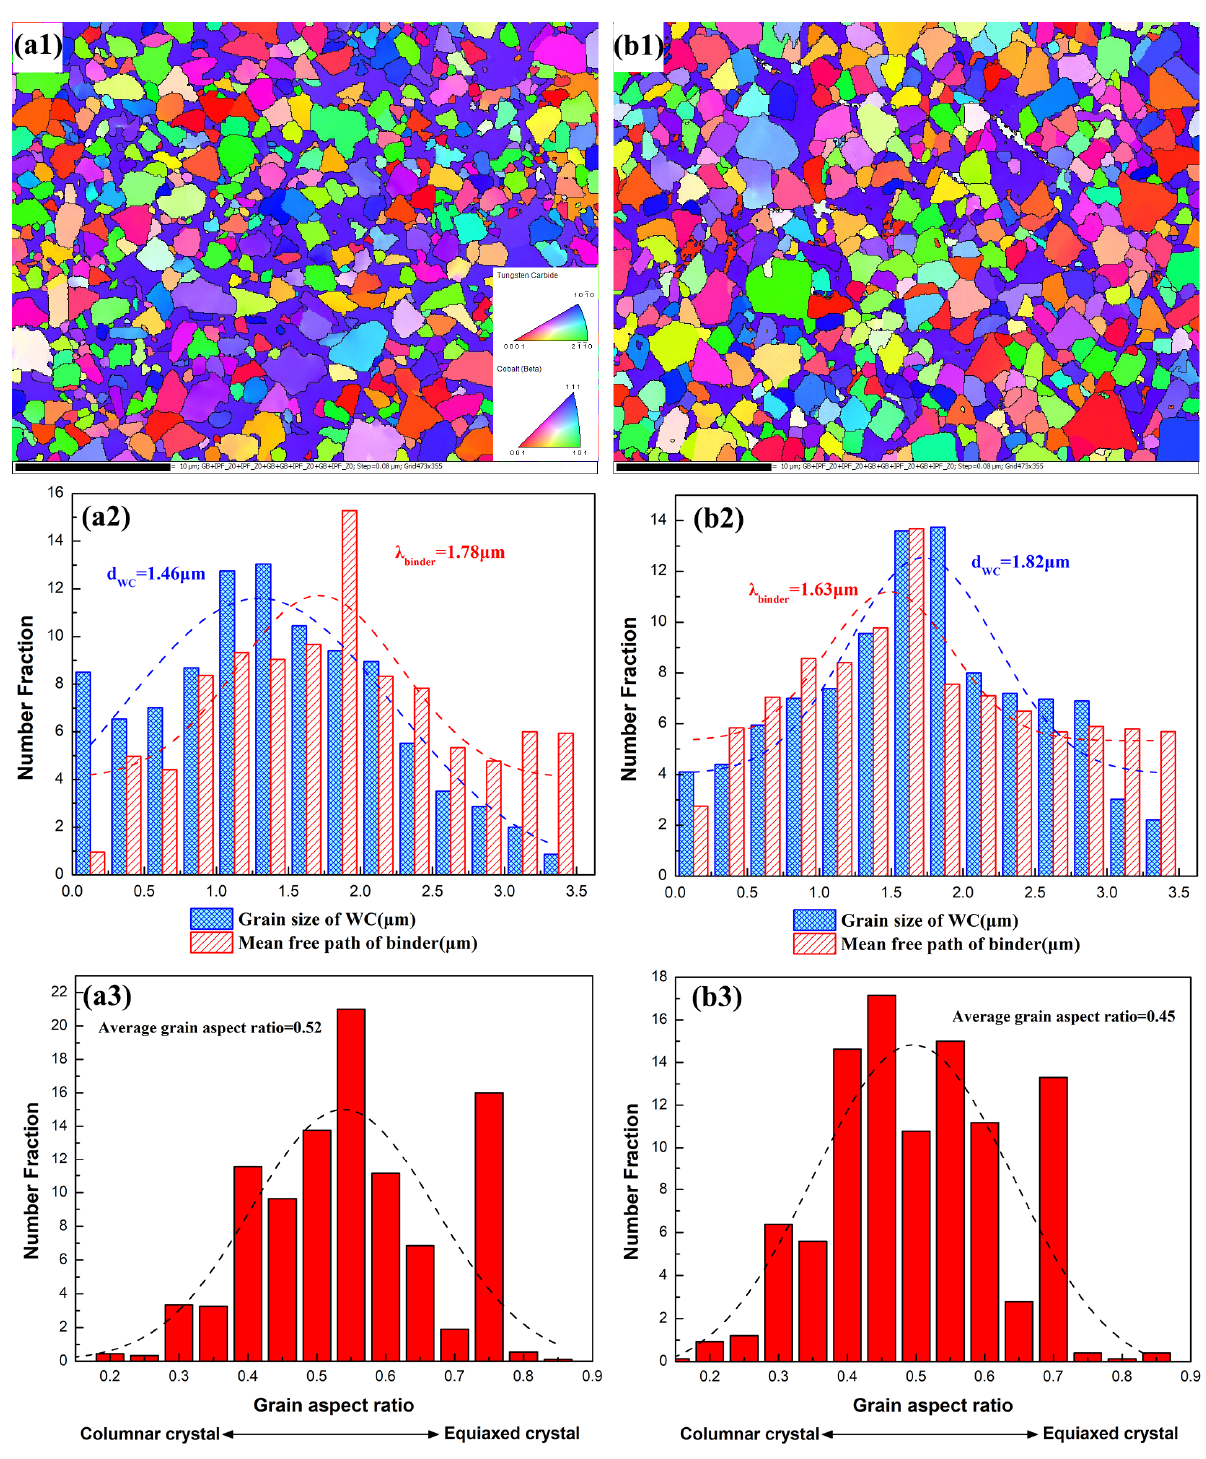
Figure 9. EBSD images of Alloy 5 and WC-Co, respectively ( a , b ): ( a1 , b1 ) inverse pole figure (IPF), ( a2 , b2 ) WC grain size and MFP distribution and ( a3 , b3 ) grain aspect ratio of WC.